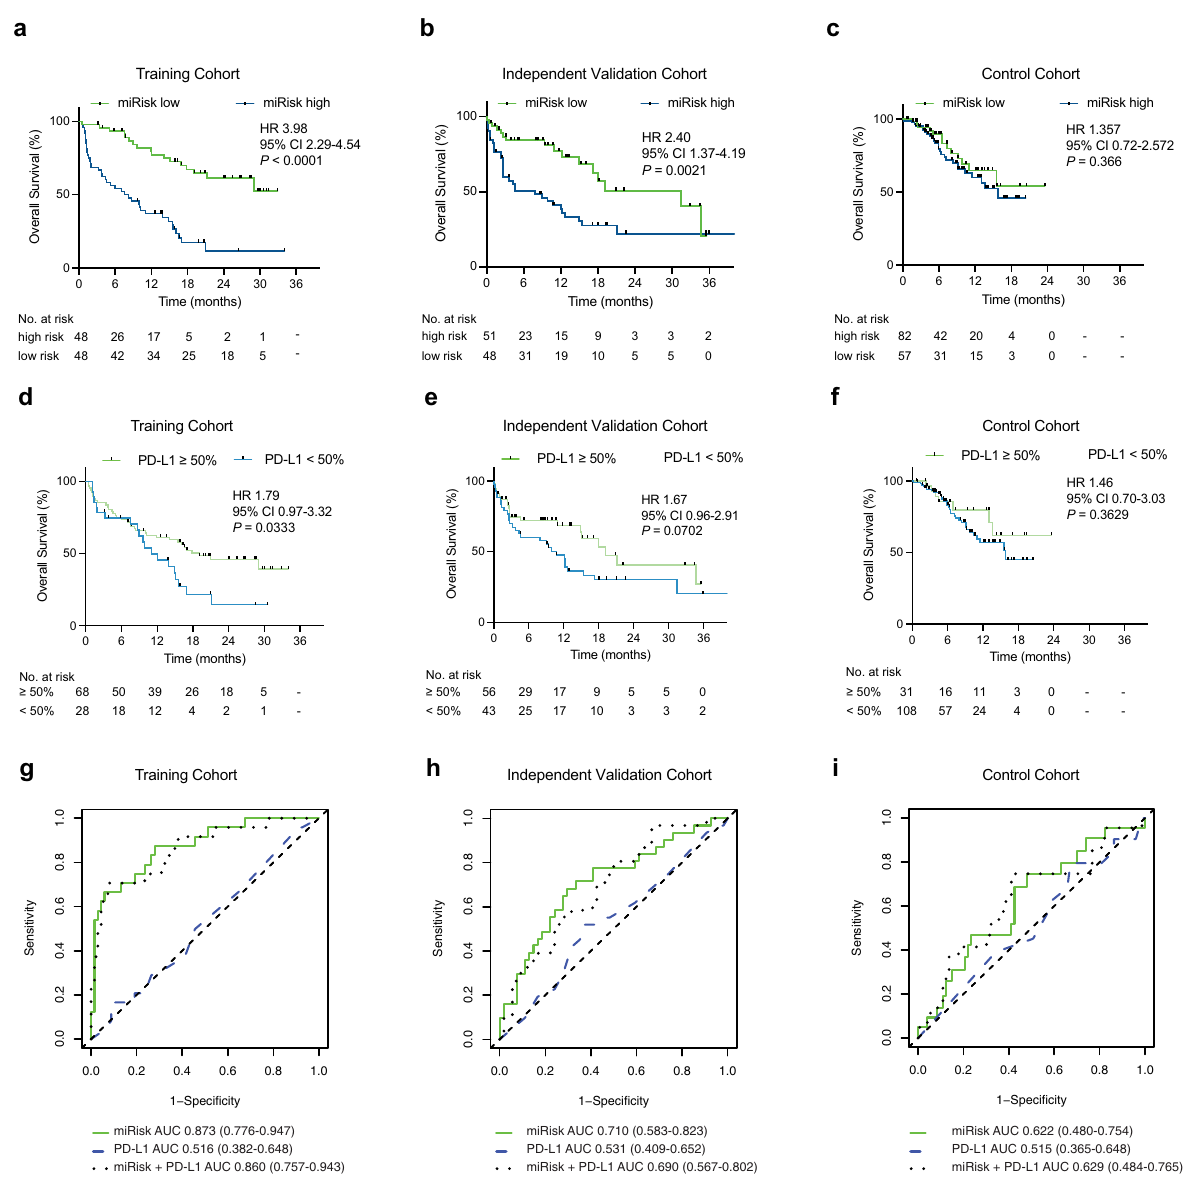
Fig. 2 Overall survival of NSCLC patients strati fi ed by miRisk score and PD-L1 TPS. a – c Comparison of OS between low/high miRisk score groups in the training ( n = 96), independent PD-(L)1 inhibitor monotherapy validation ( n = 99), and the chemoimmunotherapy control cohorts ( n = 139). Signi fi cant differences in OS are observed in the training and independent validation cohorts but not the control cohort. d , e Comparison of OS between patients strati fi ed by PD-L1 TPS in the training ( n = 96), independent validation ( n = 99), and the control cohorts ( n = 139). The differences in OS only reach signi fi cance in the training cohort. Hazard ratios (HR) and 95% con fi dence intervals were calculated using a univariable Cox regression analysis; P -values were calculated using the log-rank test. All statistical analyses were two-sided. g , h Time- dependent ROC curves (6 months) in the training, independent validation, and control cohorts, as determined by the miRisk score, PD-L1 TPS or a model incorporating the miRisk miRNAs + PD-L1 TPS. Based on the multivariable analysis (Table 2), the miRisk score is TPS and longer OS in the training and validation cohorts with an independent signi fi cant predictor of OS in all three cohorts. greater signi fi cance than that observed in the control cohort. An Additionally, ECOG is associated with OS in the validation and association between ECOG and OS is observed only in the control cohorts. The association between blood counts and OS is validation cohort (HR 2.82, 95% CI 1.47 – 5.41; P < 0.01). Across all attenuated when controlling for other covariates in the training three cohorts correlations between blood counts and OS are and validation cohorts, but not the control cohort where ANC observed, with signi fi cant association to absolute neutrophil count remains an independent signi fi cant predictor (HR 0.37, 95% CI (ANC), and non-signi fi cant associations to absolute lymphocyte 0.18 – 0.75; P < 0.01). Together, these analyses would suggest that count (ALC). The bene fi cial effect from both low ANC and high the miRisk score may have a prognostic association across the ALC is consistent with a previously published predictive signature three studied cohorts. This may be indicative of the general derived from peripheral blood counts 12 , however, the observed prognosis of late-stage NSCLC or rather related to the control association in the control cohort may be suggestive of a cohort having also received immunotherapy as part of their prognostic element to this biomarker. npj Precision Oncology (2022)